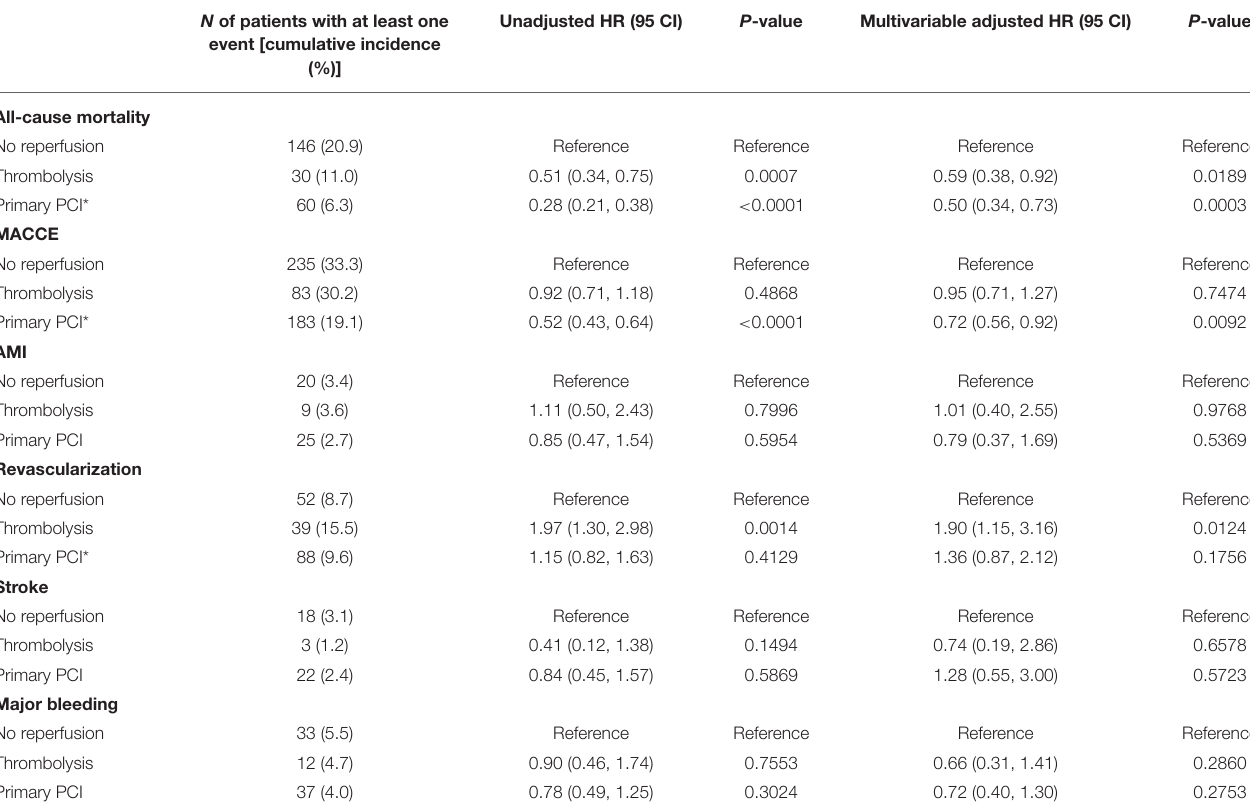
TABLE 5 | Clinical outcomes at 2-year according to treatment strategies in patients with right ventricular infarction. N of patients with at least one event [cumulative